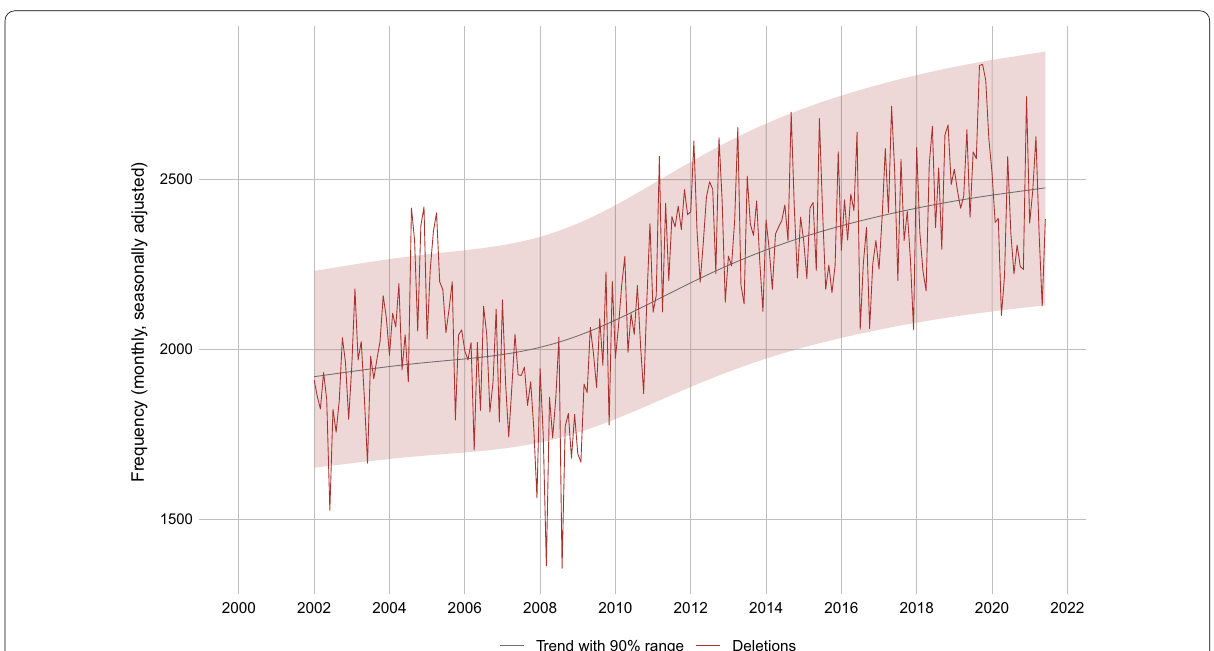
Fig. 16 Deletions of firms from the Swiss Official Gazette of Commerce. Notes : The figure shows the monthly seasonally adjusted frequency of deletions of firms from the Swiss Official Gazette of Commerce, together with a trend and the 90% probability range. Note that most of the trend increase from 2008 to 2012 was due to a law change which stipulated the counting of SCO Art. 731b cases as bankruptcies and the deletion of Art. 731b cases from the Official Gazette of Commerce